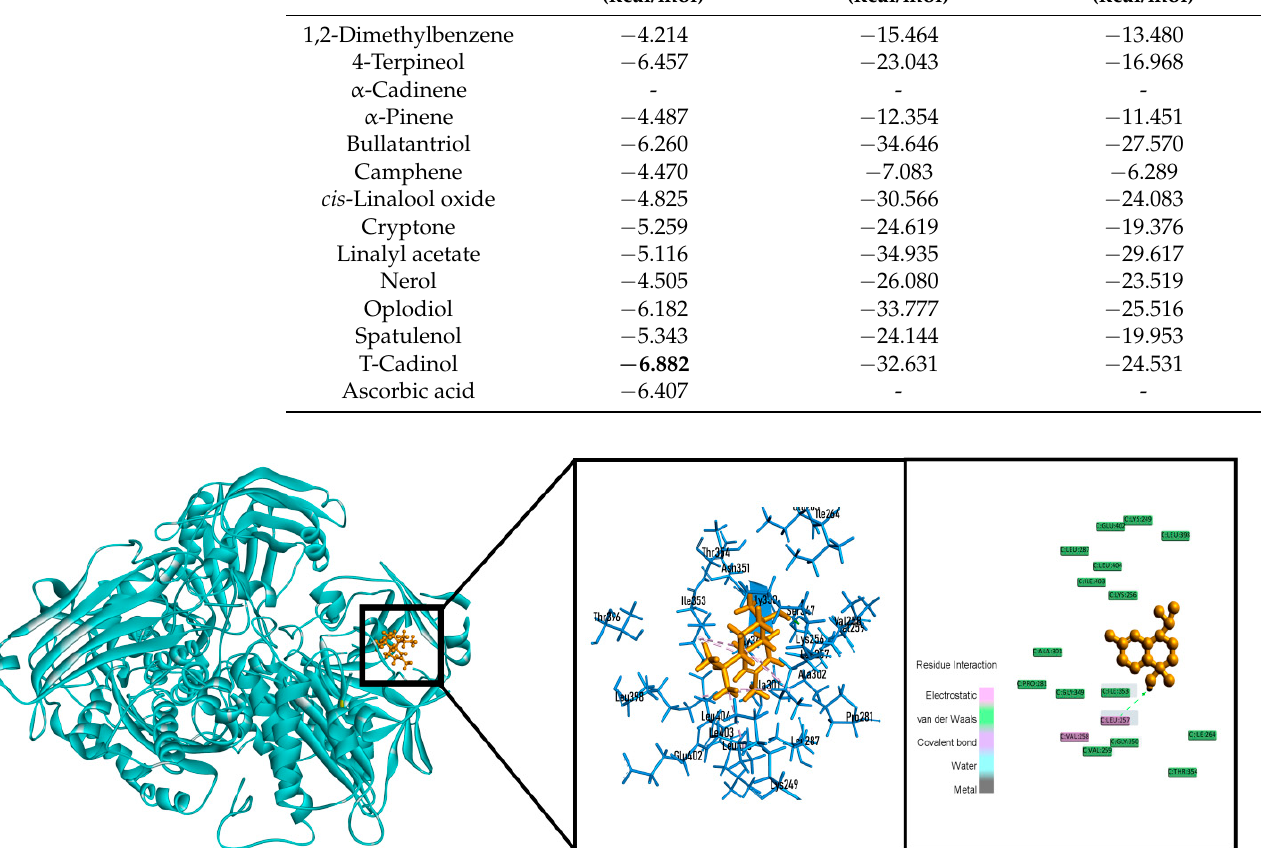
Figure 6. Best docked poses and 2D interactions of T-cadinol with xanthine oxidoreductase (PDB: 2CKJ) for antioxidant activity.